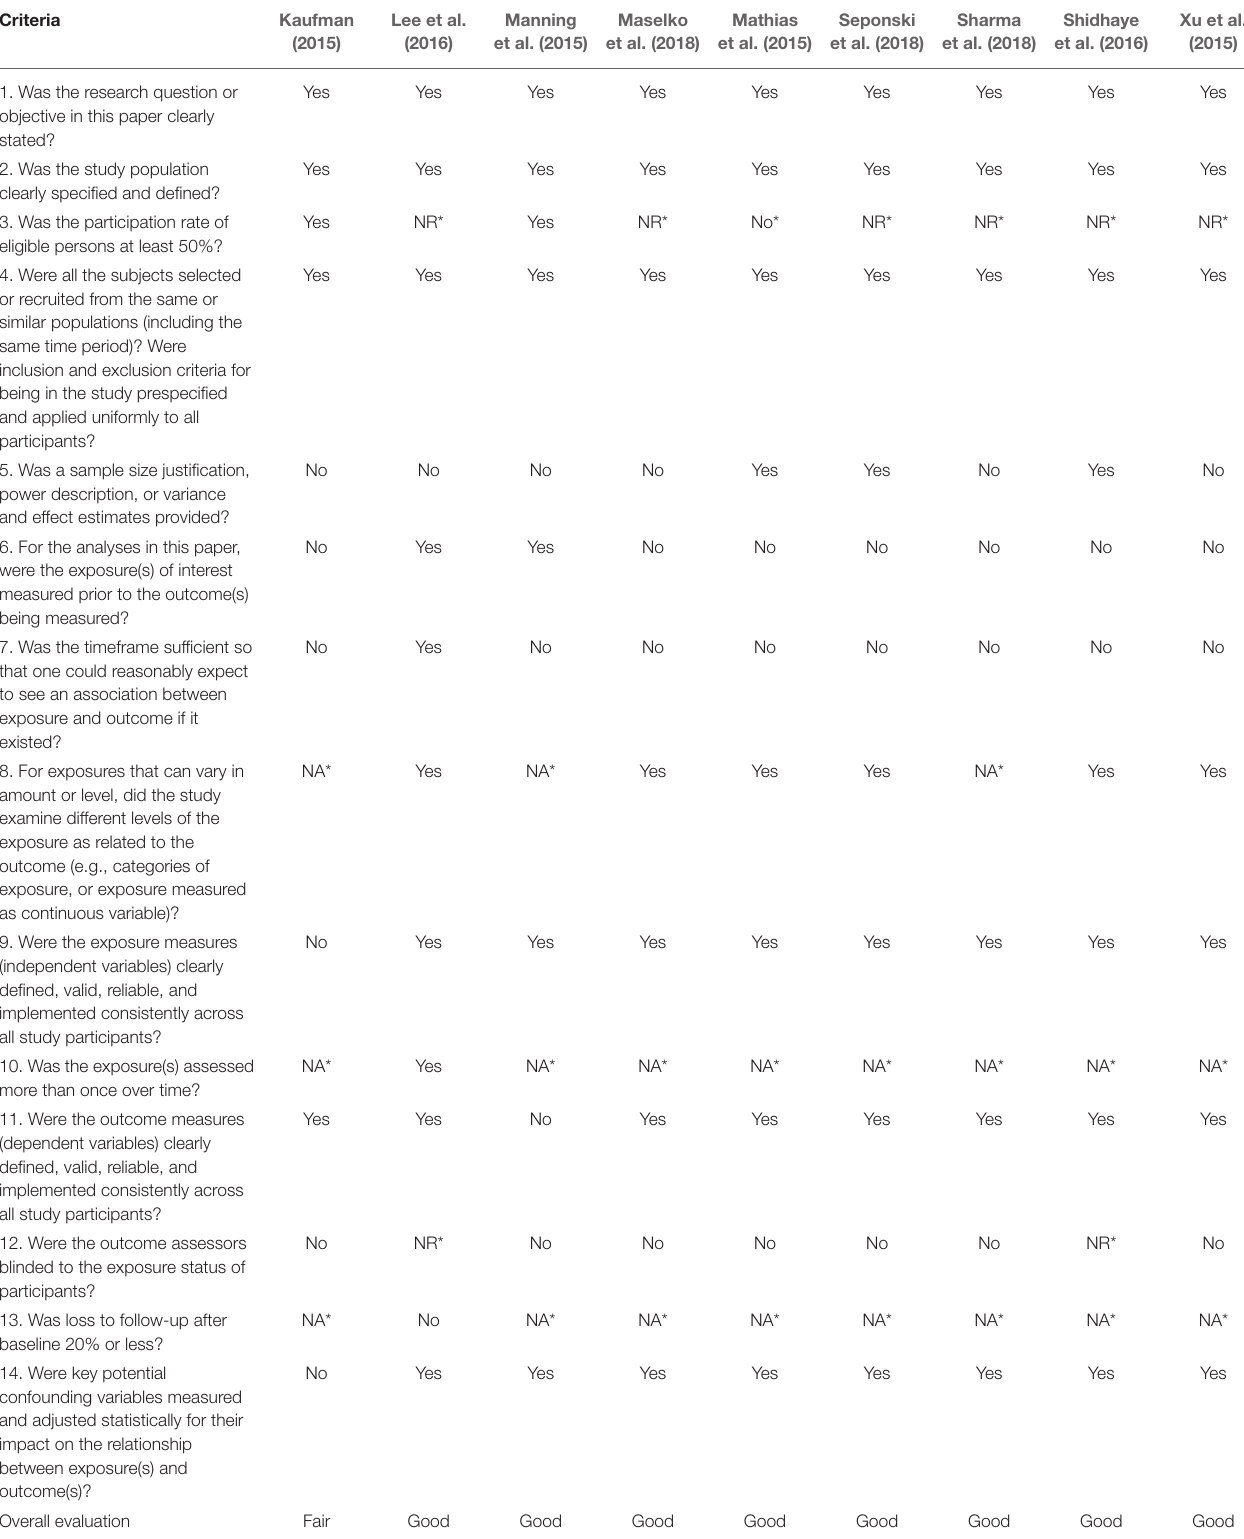
TABLE 4 | Summary of Risk of Bias.